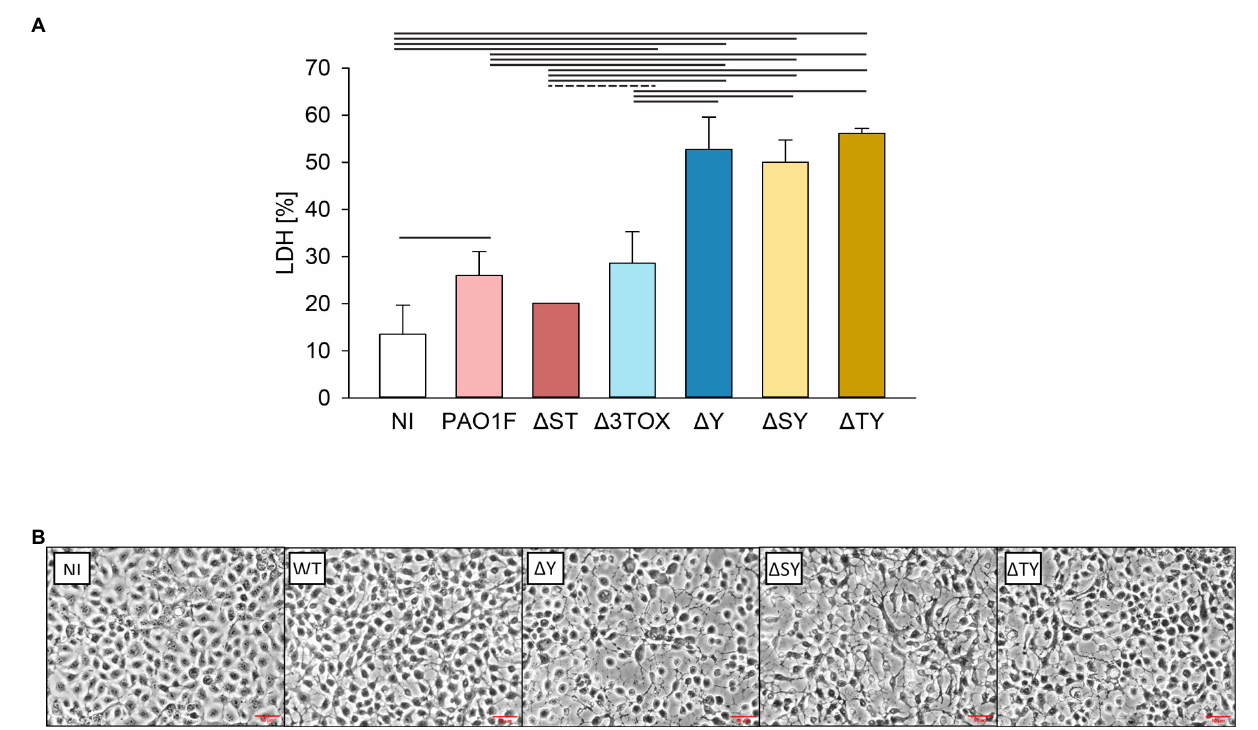
FIGURE 6 | Lactate dehydrogenase release (A) and morphology (B) of lung bronchial NCI-H292 epithelial cells infected by P. aeruginosa T3SS exotoxin mutants for 3 h at MOI 20. (A) Cytotoxicity was assessed based on the amount of LDH released by the epithelial cells into the culture supernatant determined as % of total cell LDH. Mean values and SD were calculated from two independent measurements with four technical replicates each taken using the CytoTox 96 ® Non- Radioactive Cytotoxicity Assay kit. (B) Microscopic images of epithelial cells infected by the P. aeruginosa strains. Images were taken under 20x objective using a Nikon Eclipse 80i microscope with a DS-U1 camera. The experiment was performed two times and representative images are shown. NI, non-infected control; PAO1F, wild-type (WT) expressing exoS , exoT , and exoY ; Δ ST , only exoY expression; Δ 3TOX no T3SS effector gene expression; Δ Y , exoS and exoT expression; Δ SY , only exoT expression; and Δ TY , only exoS expression. Red lines indicate the scale of 50 μ M. One way ANOVA analysis with subsequent pairwise comparison (Turkey method) revealed significant differences between pairs connected by solid lines or dashed lines indicating values of p < 0.001 or 0.025,